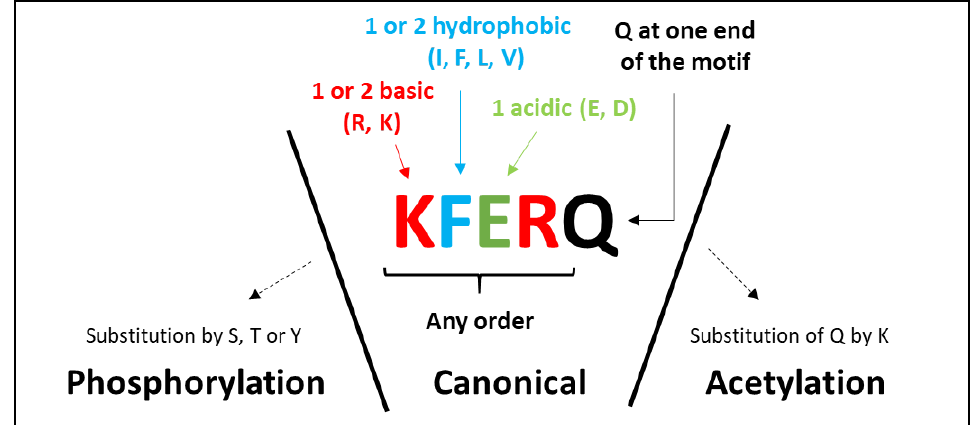
Figure 2. Building rules of canonical, phosphorylation-, and acetylation-generated KFERQ-like motifs (adapted from [21]). The KFERQ-like motif may contain up to two hydrophobic residues (isoleucine (I), phenylalanine (F), leucine (L), or valine (V)), up to two positive residues (arginine (R) or lysine (K)), and a single negatively-charged residue (glutamate € or aspartate (D)) flanked at either the N- or C-terminus of the pentapeptide by a single glutamine (Q) residue. KFERQ-like motifs can also be generated via post-translational modifications, such as phosphorylation or acetylation of the amino acid residues along protein regions that do not originally show the mentioned properties.